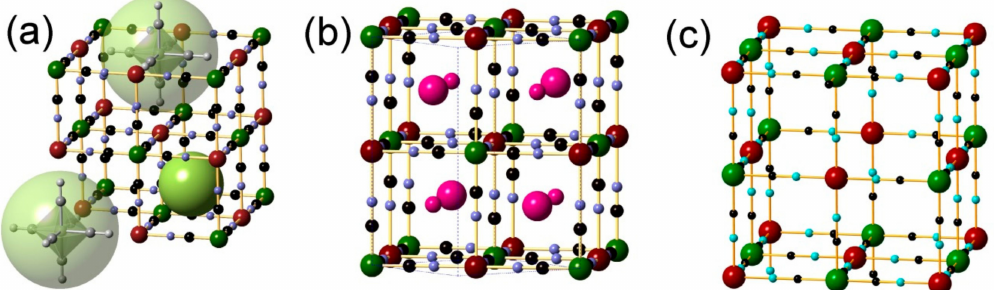
Figure 1. Illustration of Prussian blue analogues (PBA) and Prussian blue (PB) structures. Red, green, black and blue spheres represent M, M’, C and N atoms, respectively: ( a ) Dehydrated M’[M(CN) 6 ] z PBA structure, with space-group symmetry Fm 3 m and a ≈ 10 Å. The atomic positions of two absent M(CN) 6 molecules leading to two large cavities are illustrated by large transparent green spheres and one small cavity by a light green sphere; ( b ) The related tetragonal structure, space group symmetry I -4 m 2, of water-containing CsCu[Fe(CN) 6 ] · n H 2 O. Large and small pink spheres represent di ff erent occupancies of Cs + ions in the small cavities, which also contain H 2 O molecules. The tetragonal unit cell is outlined by dotted lines; ( c ) The structure of dehydrated ordered PB Fe[Fe(CN) 6 ] 3 / 4 , with an ordered arrangement of 25% Fe 2 + (CN) 6 vacancies and Pm 3 m space group